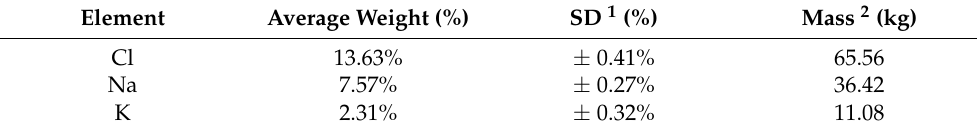
Table 2. Raw salt slag analyses.